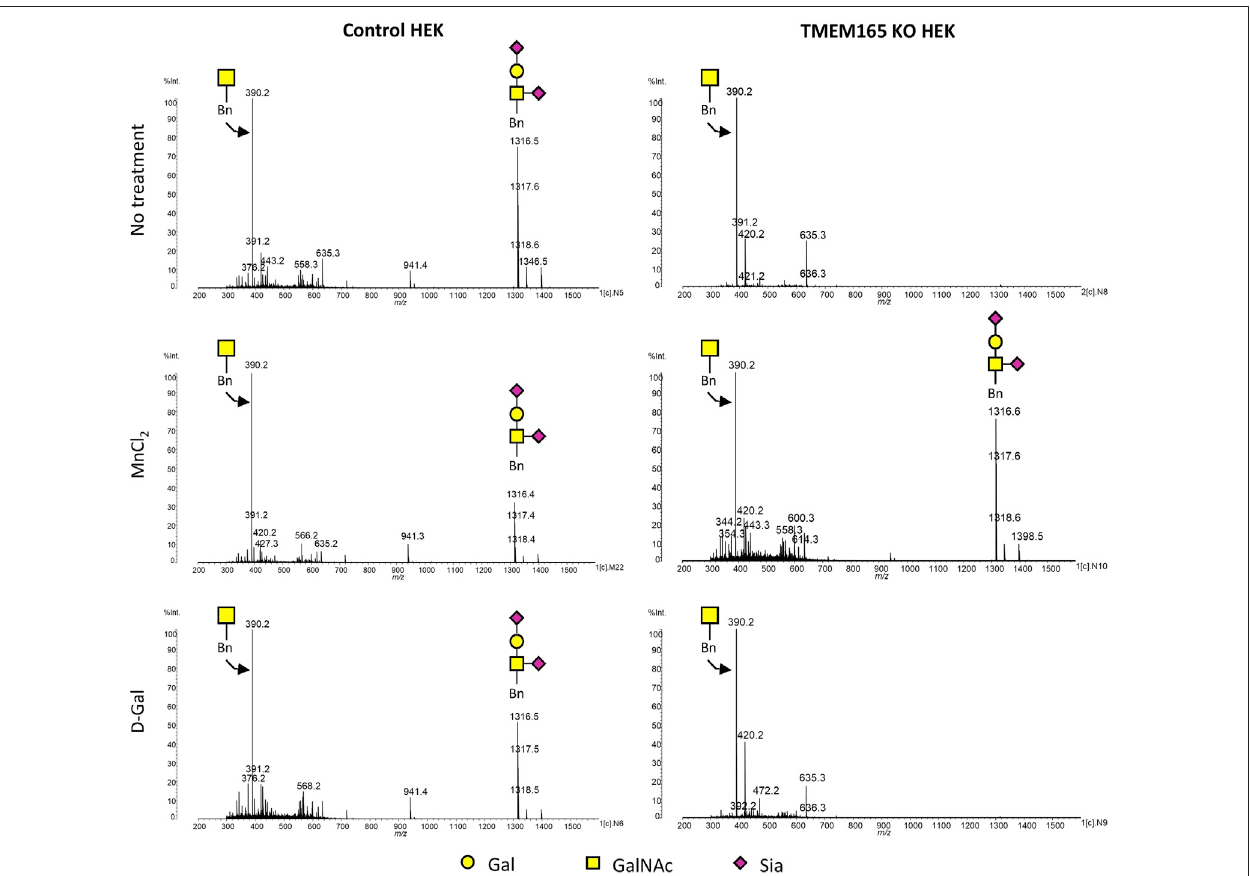
FIGURE 4 | Mass spectrometry analysis of the Benzyl-GalNAc glycosylation status in HEK cells treated with MnCl 2 or D-Galactose. MALDI-TOF MS spectra were obtained from control and TMEM165 KO HEK cells, treated or not with 1 mM D-Gal or 2.5 µM of MnCl 2 and incubated with Bn-GalNAc at 250 µM for 3 days. Glycan structure of each peak of interest is schematized. Symbols used to represent the different sugar residues are indicated at the bottom of the fi gure. Gal, galactose; GalNAc, N -acetylgalactosamine and Sia, sialic acid.